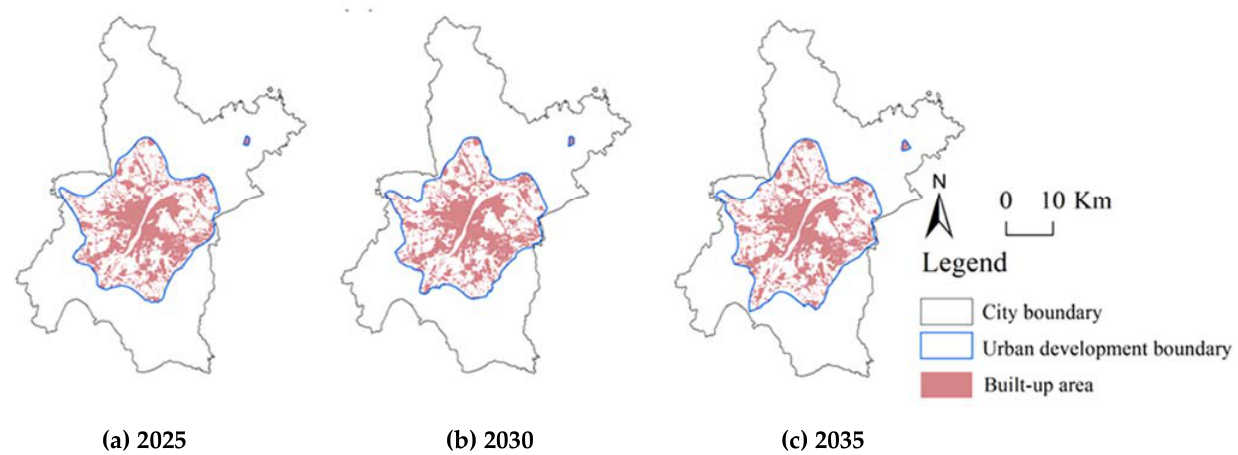
Figure 8. Urban development boundary for ( a ) 2025, ( b ) 2030, and ( c ) 2035 simulated by the MCR model.